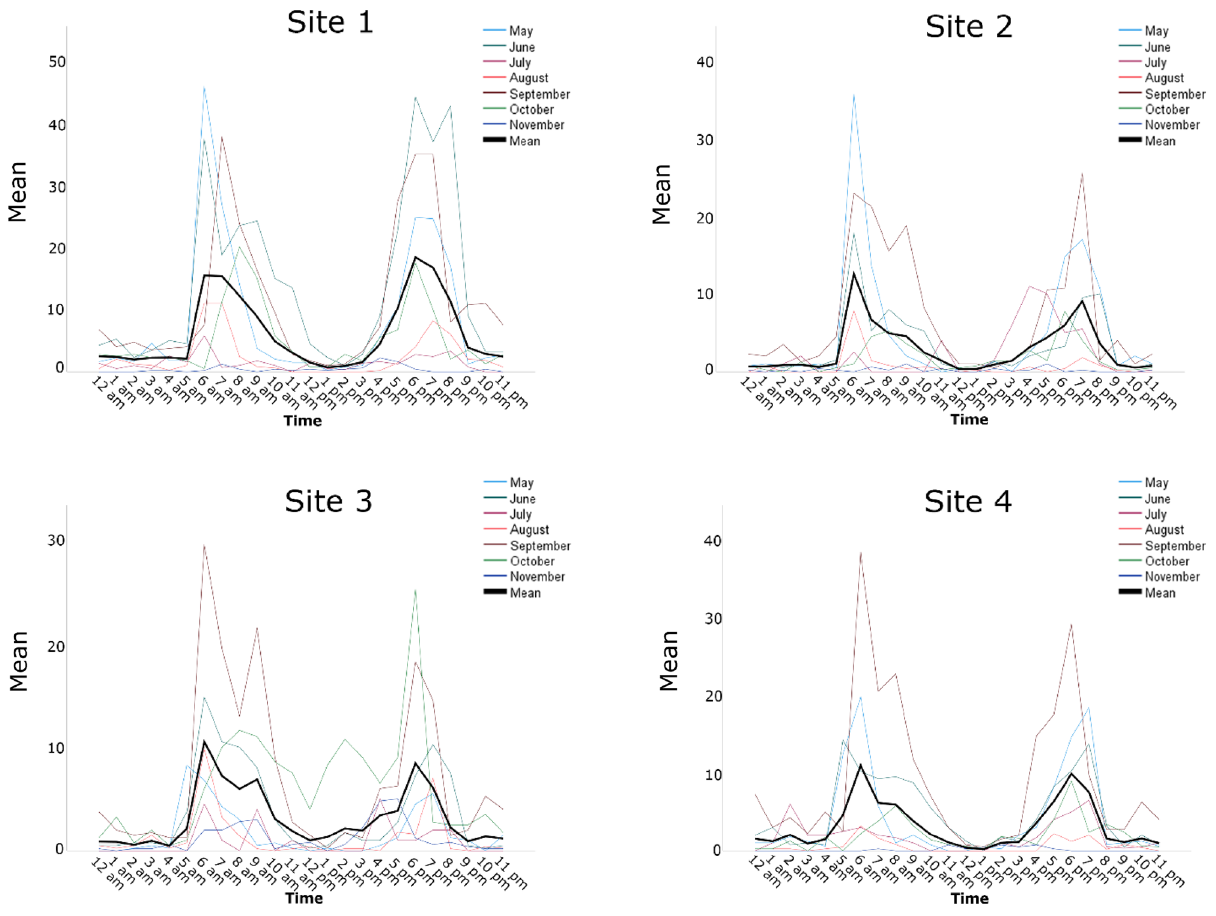
Figure 2. Diel activity patterns for Ae. aegypti populations at each of the 4 sampling sites in Brownsville, Texas. “Mean” on the graphs represent the mean number of female Ae. aegypti mosquitoes captured per trap/hour. The thick black line is the mean number of Ae. aegypti female mosquitoes captured per trap/hour throughout the study period from May to November 2019.